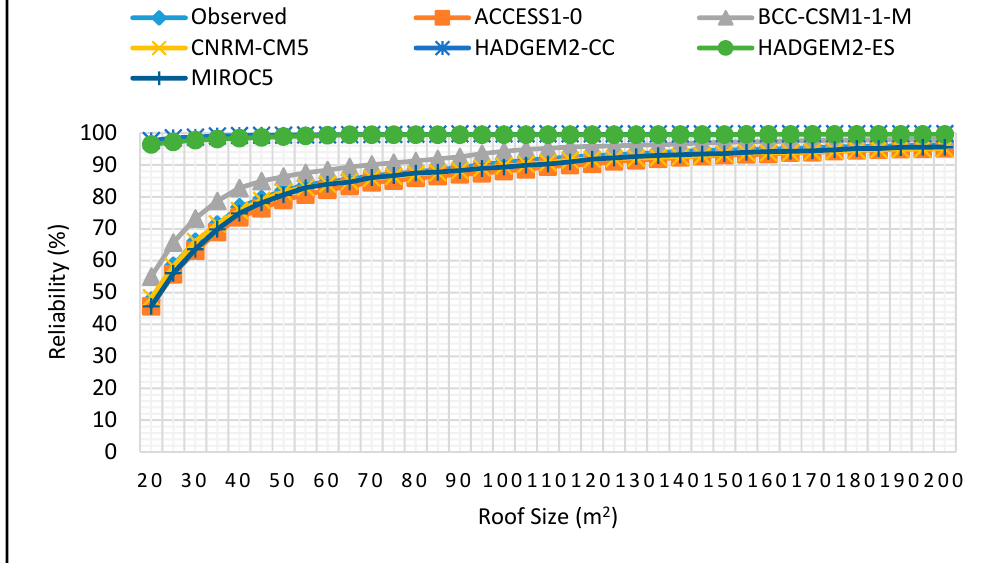
Figure 37. Reliability projections for SON season for 1 m 3 tank size for 2060–2090 period.